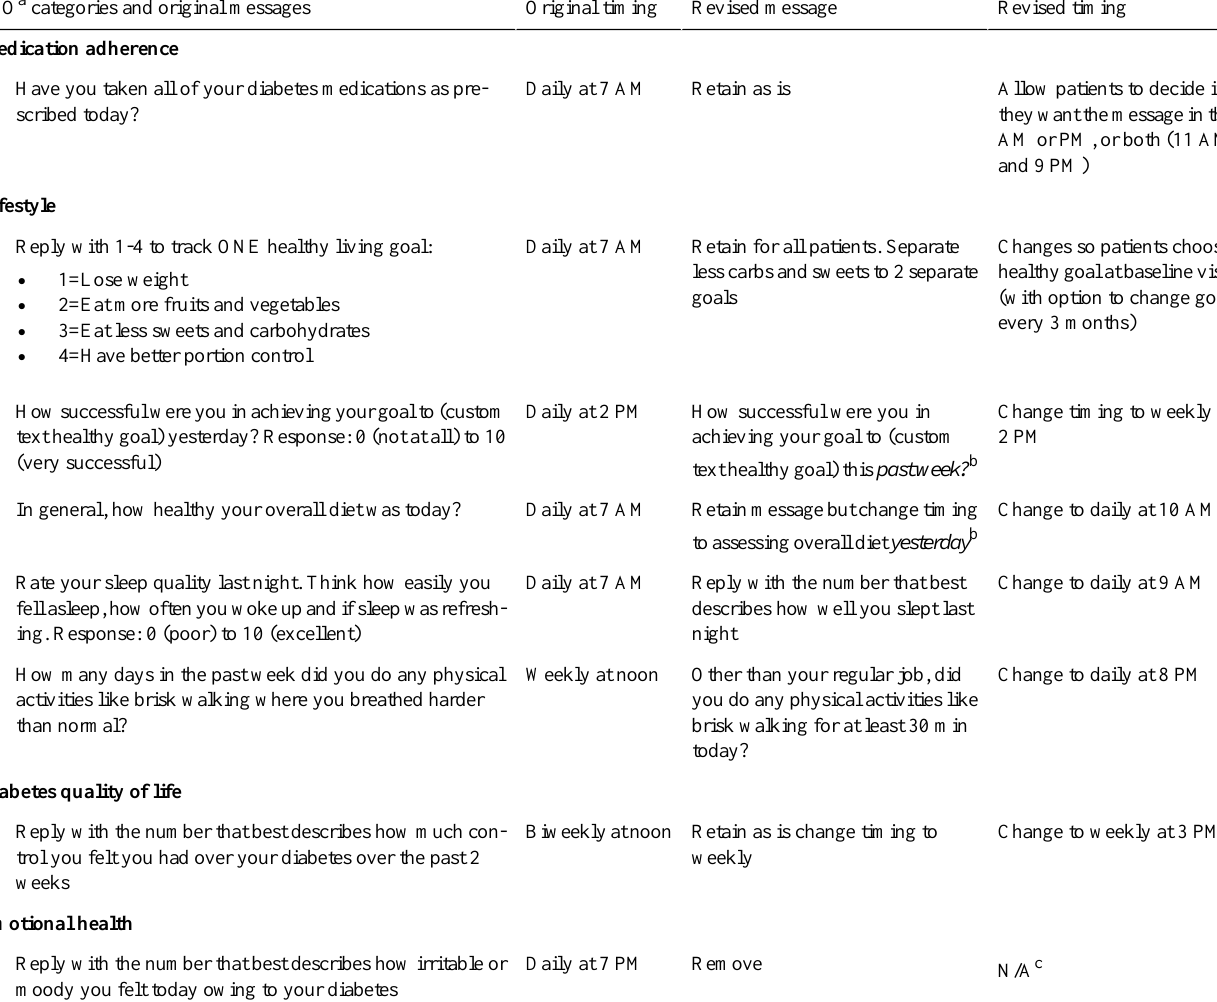
Table 7. Recommended changes to patient-reported outcome text messages from user testing